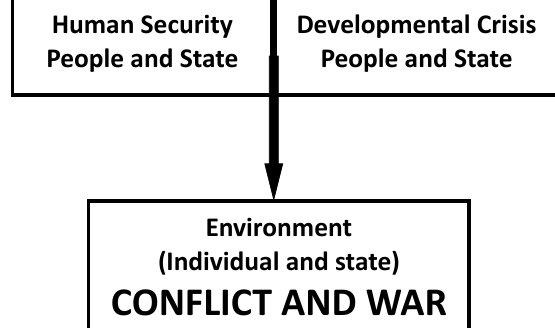
Figure 1. The interface between human security and developmental